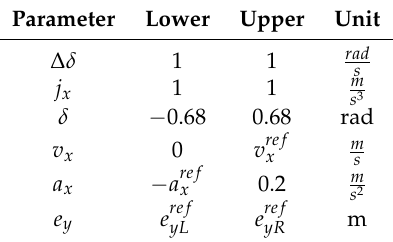
Table 3. Constraints in the low-level